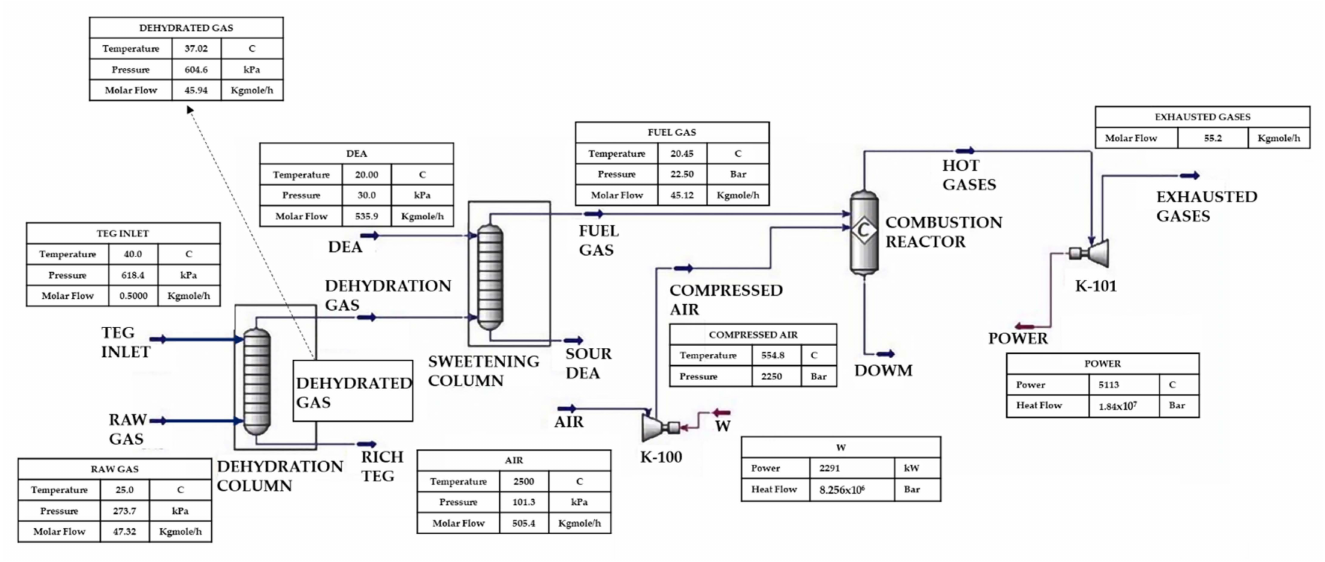
Figure 3. Aspen HYSYS simulation